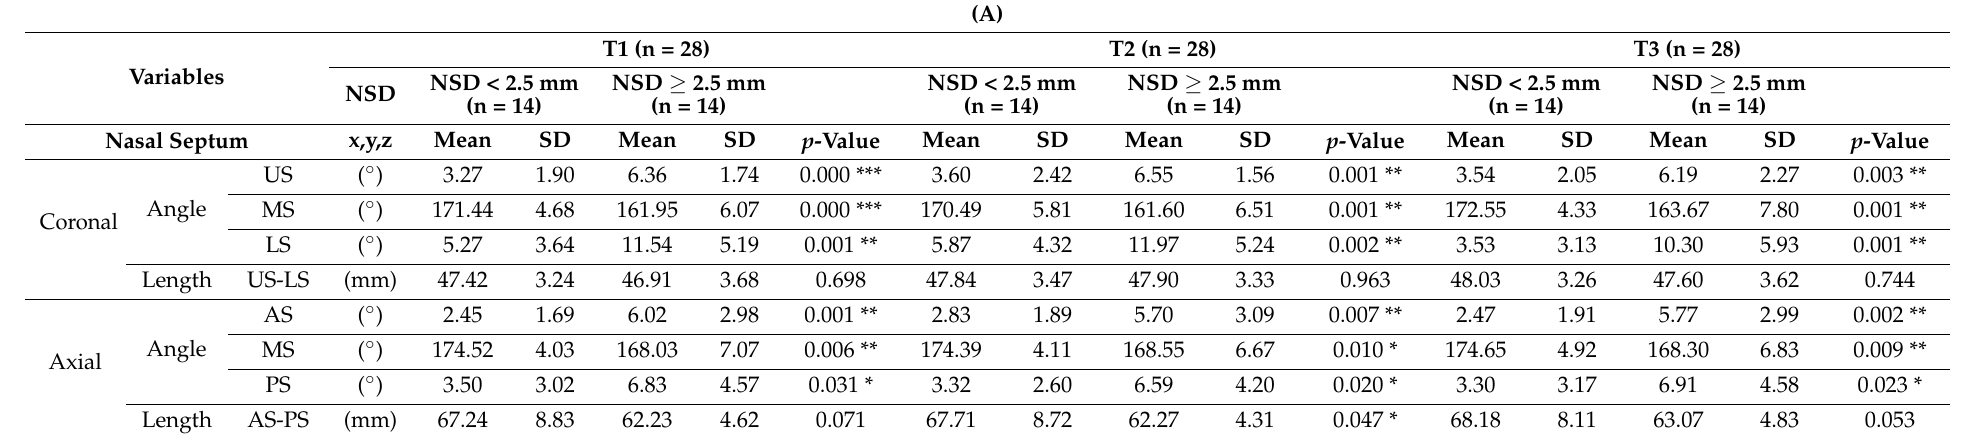
Table 5. Three-dimensional values (A) and changes (B) of nasal septum and nasofacial structures after MSE depending on the amount of